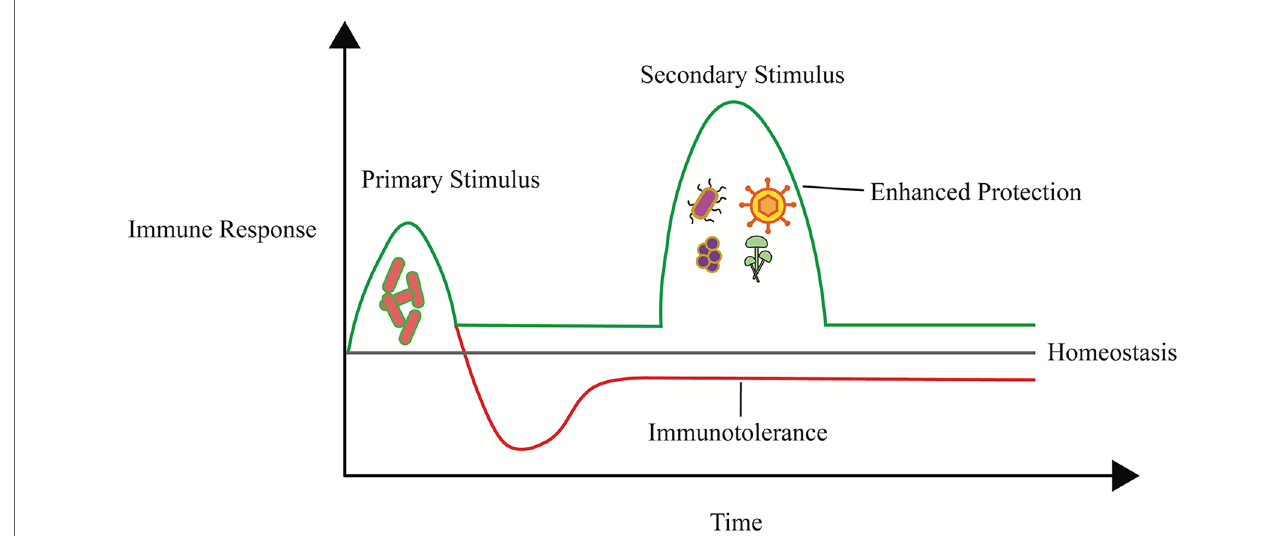
FIGURE 1 Host microbiota prime immune cells against pathogens or promote immunotolerance. Graph depicting immune training in which a primary stimulus either primes immune responses to protect against or tolerate microbial